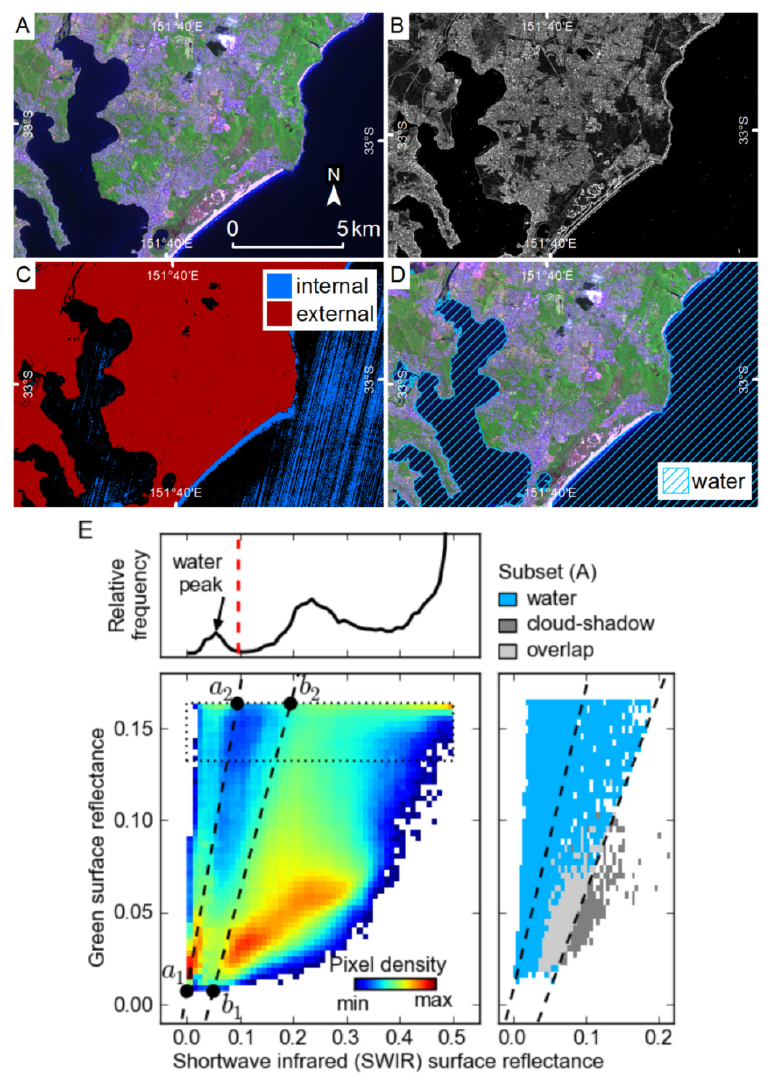
from cloud-shadows [21]. Pixels in the water mask are also used as external markers when growing cloud and shadow segments with the watershed transform. For each image this method defines linear thresholds in green-SWIR space based on features in the 2-dimensional (2D) histogram constructed from those image bands. An example of this method for image 9 is shown in Figure 6, and two further examples of the thresholds and 2D histograms from images 1 and 7 are shown in Figure 7A. Figure 6. ( A ) An example of creating the water mask for image 9. The subset is shown with bands 4, 3, 1 as red, green and blue; ( B ) The sum of the morphological gradient of all bands is used to define the edges of the water bodies, shown as greyscale where white is high and black is low; ( C ) Internal and external marker pixels for water; ( D ) Water mask grown using the watershed from markers algorithm; ( E ) Histograms used to define marker pixels. The dotted black line on the lower 2-dimensional histogram defines the area used to create the upper histogram, while the red dashed line defines the right-hand edge of the . This method allows most water to be masked, while water peak and the position of a 2 cloud shadows that have very similar spectral properties to water are